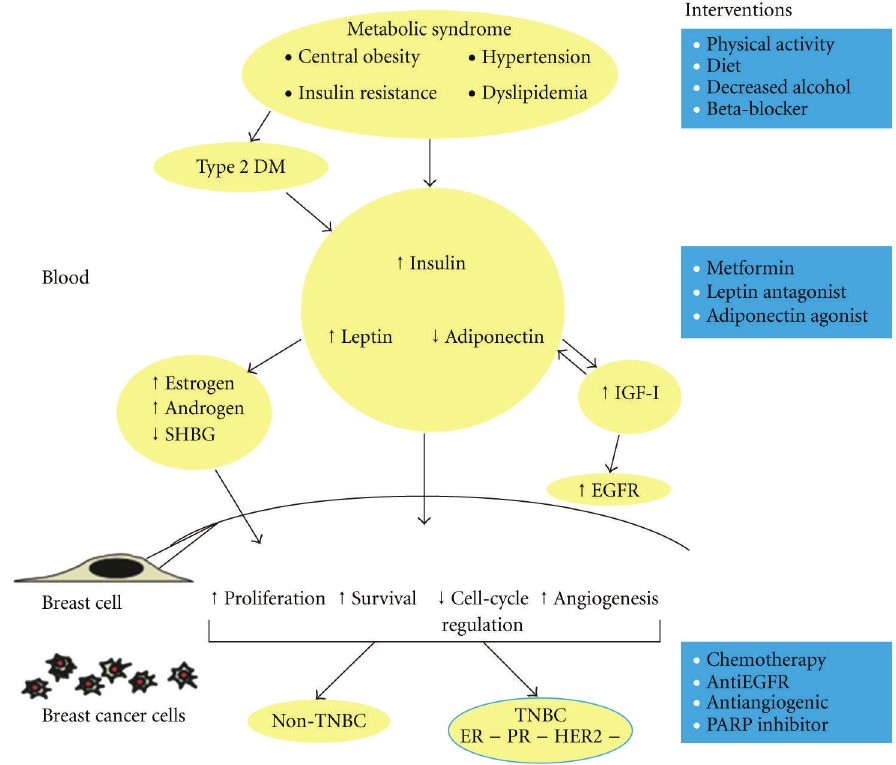
Figure 1: The insulin-leptin-adiponectin axis and risk of TNBC. Schematic representation demonstrates interactions of components in blood. After the compounds enter a normal breast cell, changes in proliferation, survival, cell-cycle regulation, and angiogenesis result in tumorigenesis of either TNBC or non-TNBC. Potential interventions for TNBC, at di ff erent levels, are included on the right.